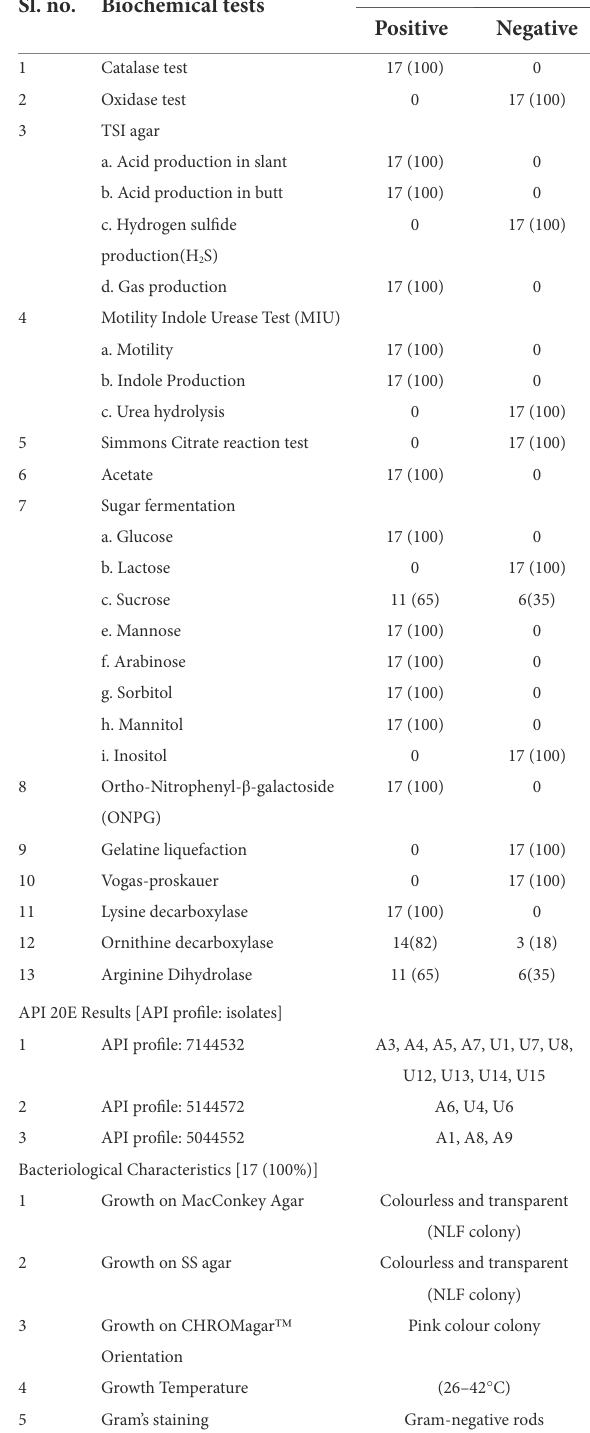
TABLE 1 Microbiological and biochemical characteristics of 17 NLF E. coli